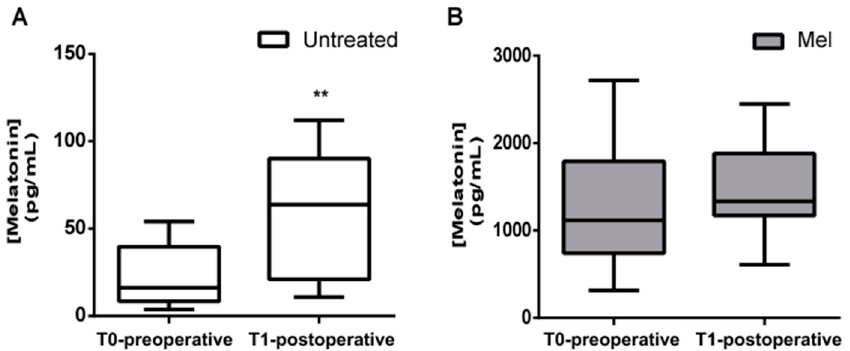
Figure 2. Preoperative and postoperative plasma melatonin concentrations (pg/mL). Plasma mela- tonin concentration evaluated before (T0-preoperative) and after (T1-postoperative) surgery in ( A )